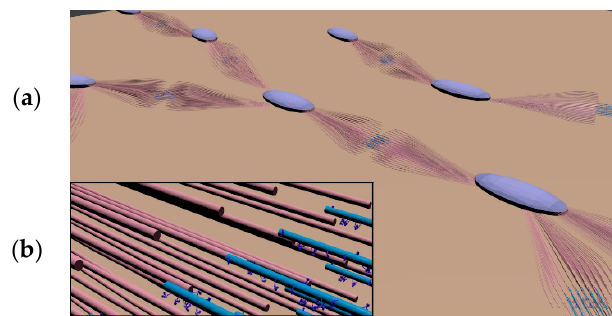
Figure 6. ( a ) A predicted filament structure model for smooth muscle. Cyan ellipsoids designate the dense body that binds actin filaments depicted in red. Actin filaments were bundled to form a broom- like structure. Two of these structures will hold a myosin filament with protruding myosin heads. A motor protein is depicted in blue. ( b ) A magnified view of the actin and myosin filaments interacting on the overlapped regions.